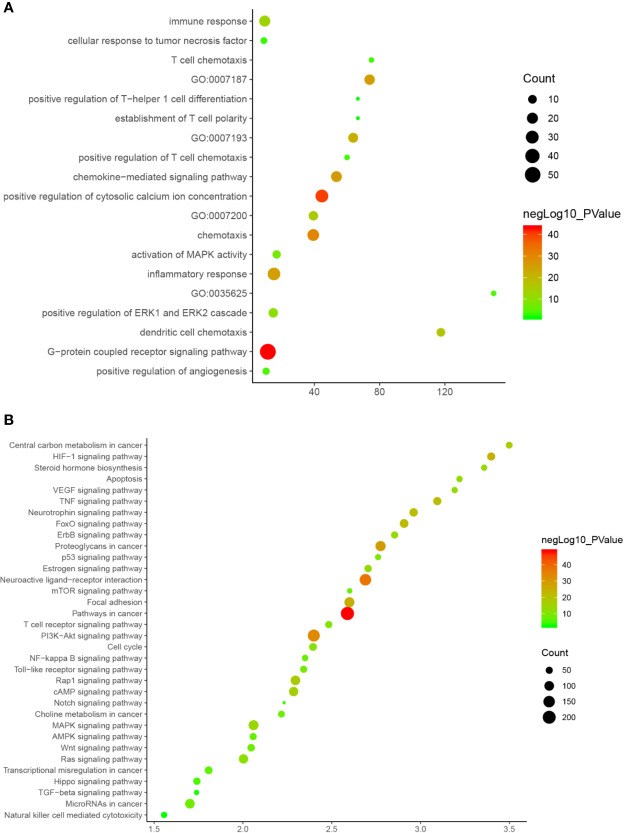
Bubble chart (A) biological processes; (B) signaling pathway. X-axis stand for fold enrichment.